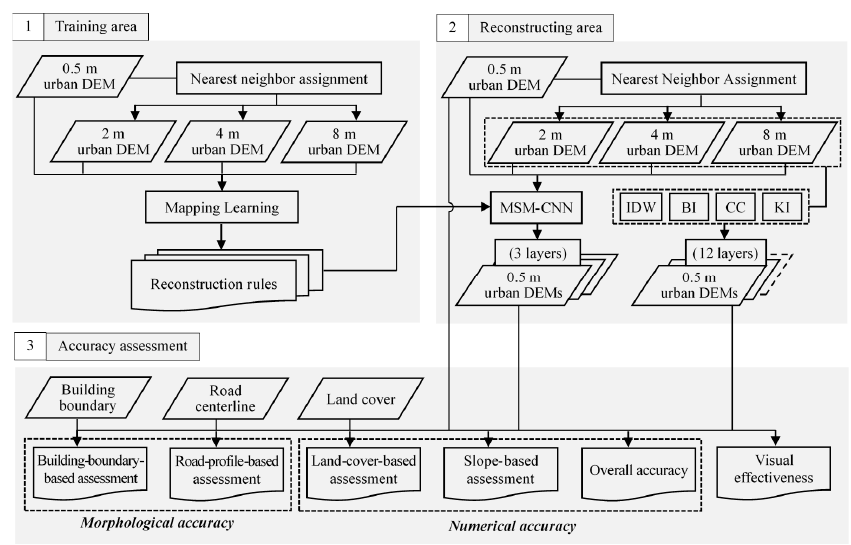
Figure 3. Experimental setup.